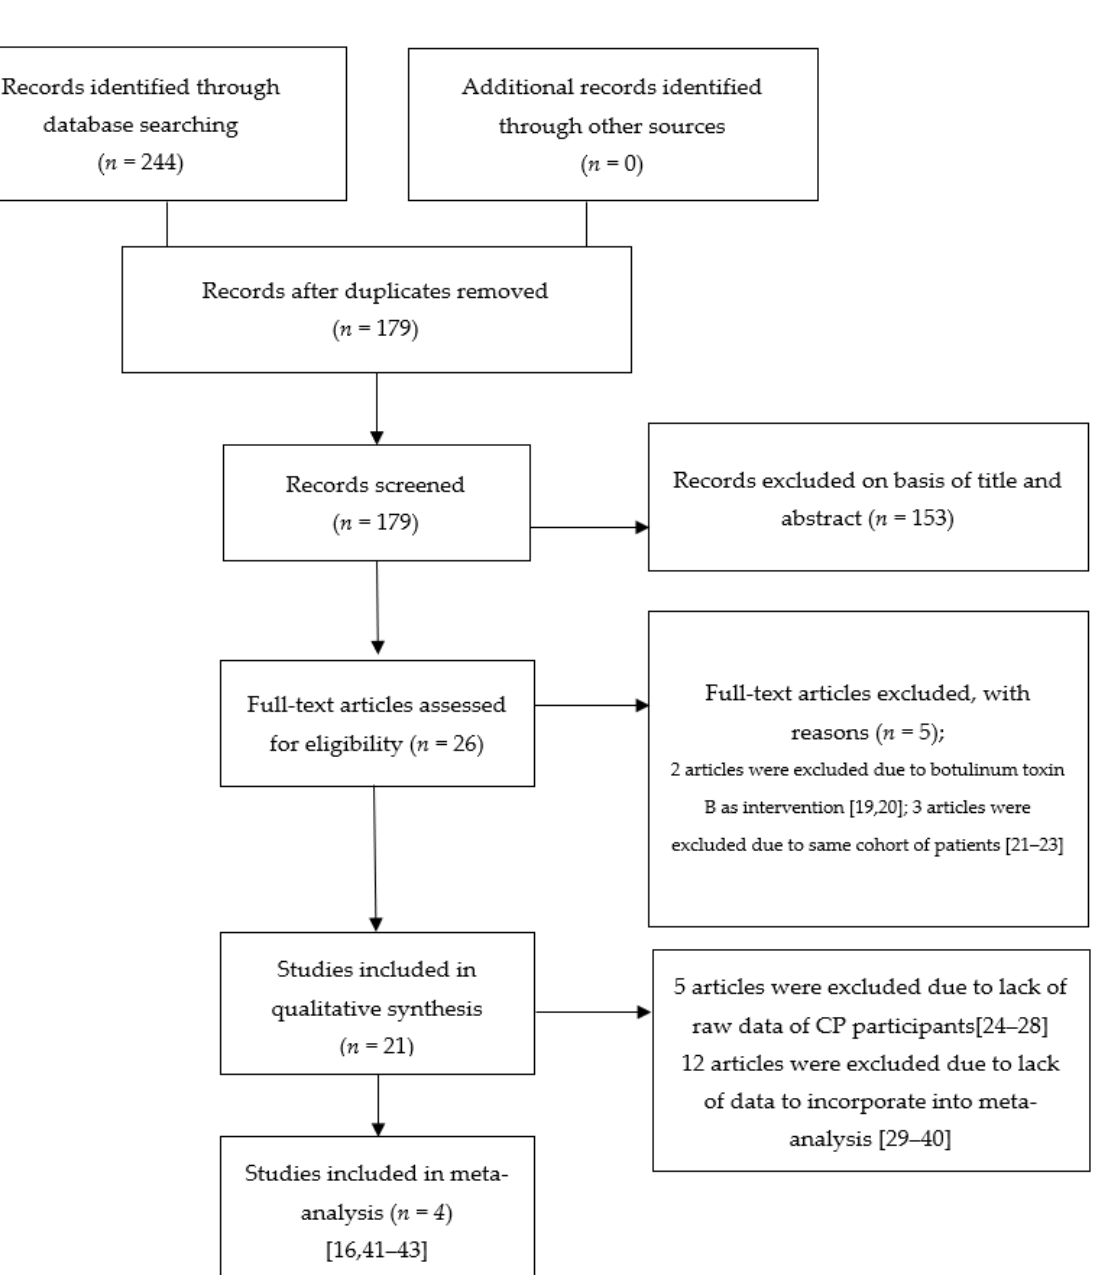
Figure 1. Included and excluded studies.